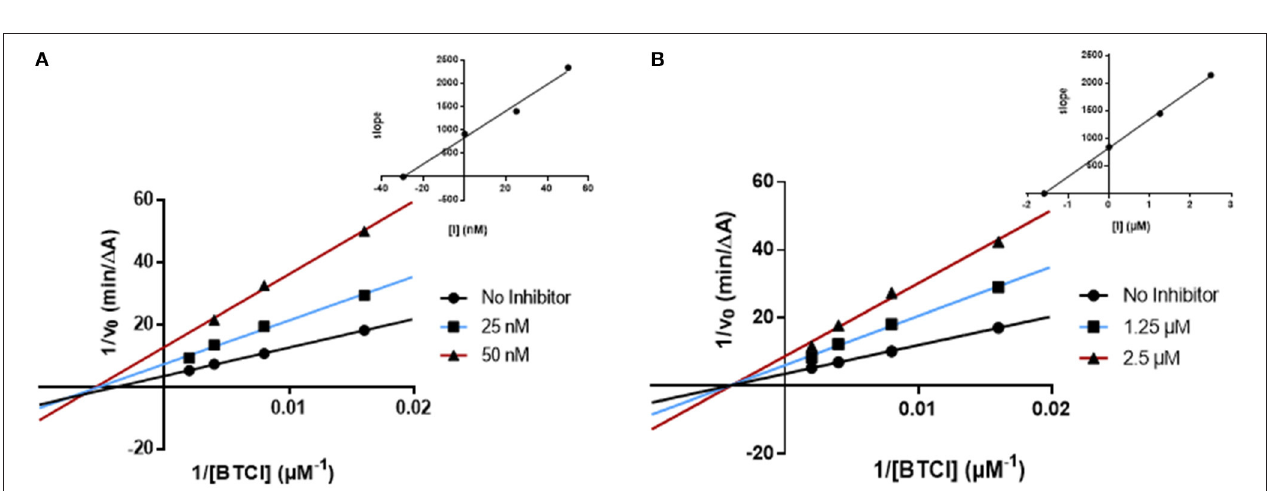
FIGURE 5 | Kinetic studies on the mechanism of BChE inhibition by (A) AntiOxBEN 1 and (B) donepezil. The effect of the inhibitors on the enzyme was determined from the double reciprocal plot of 1/rate (1/V) vs. 1/substrate concentration in presence of varying concentrations of the inhibitors. The Ki values were calculated by the intersection of the curves obtained by plotting 1/V vs. the inhibitor concentration for each substrate concentration (Dixon plots insets on the top